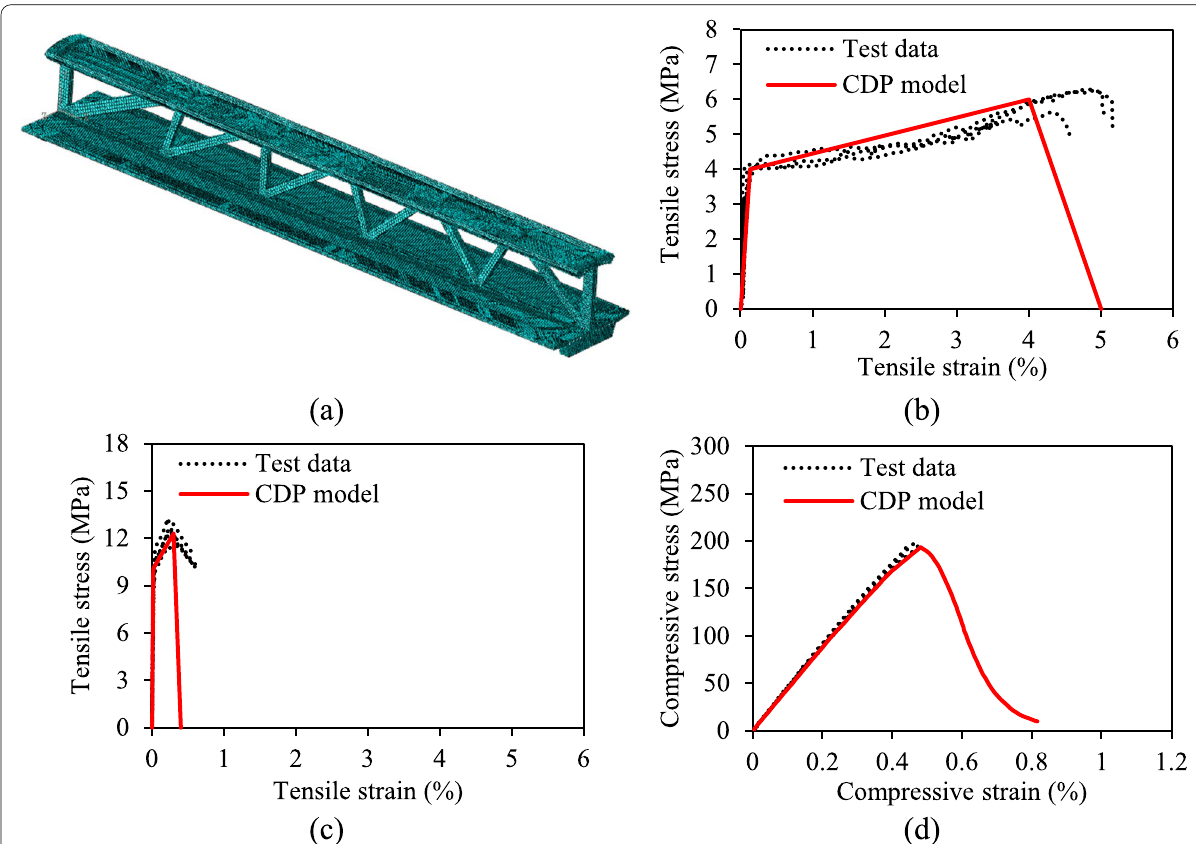
Fig. 9 Finite element model of the bridge: a meshed model; b tensile properties of SHCC [46]; c tensile properties of UHPC [47]; and d compressive properties of UHPC [48,